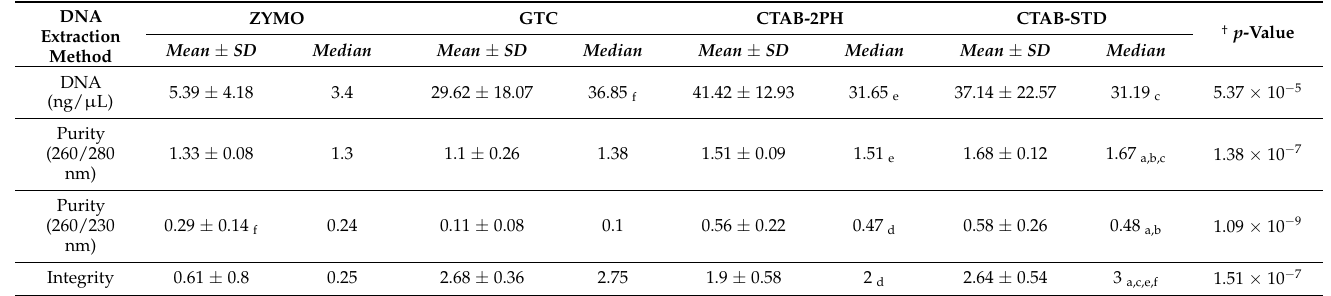
Table 1. Summary of the quantity and quality of human milk DNA extraction by the DNA extraction